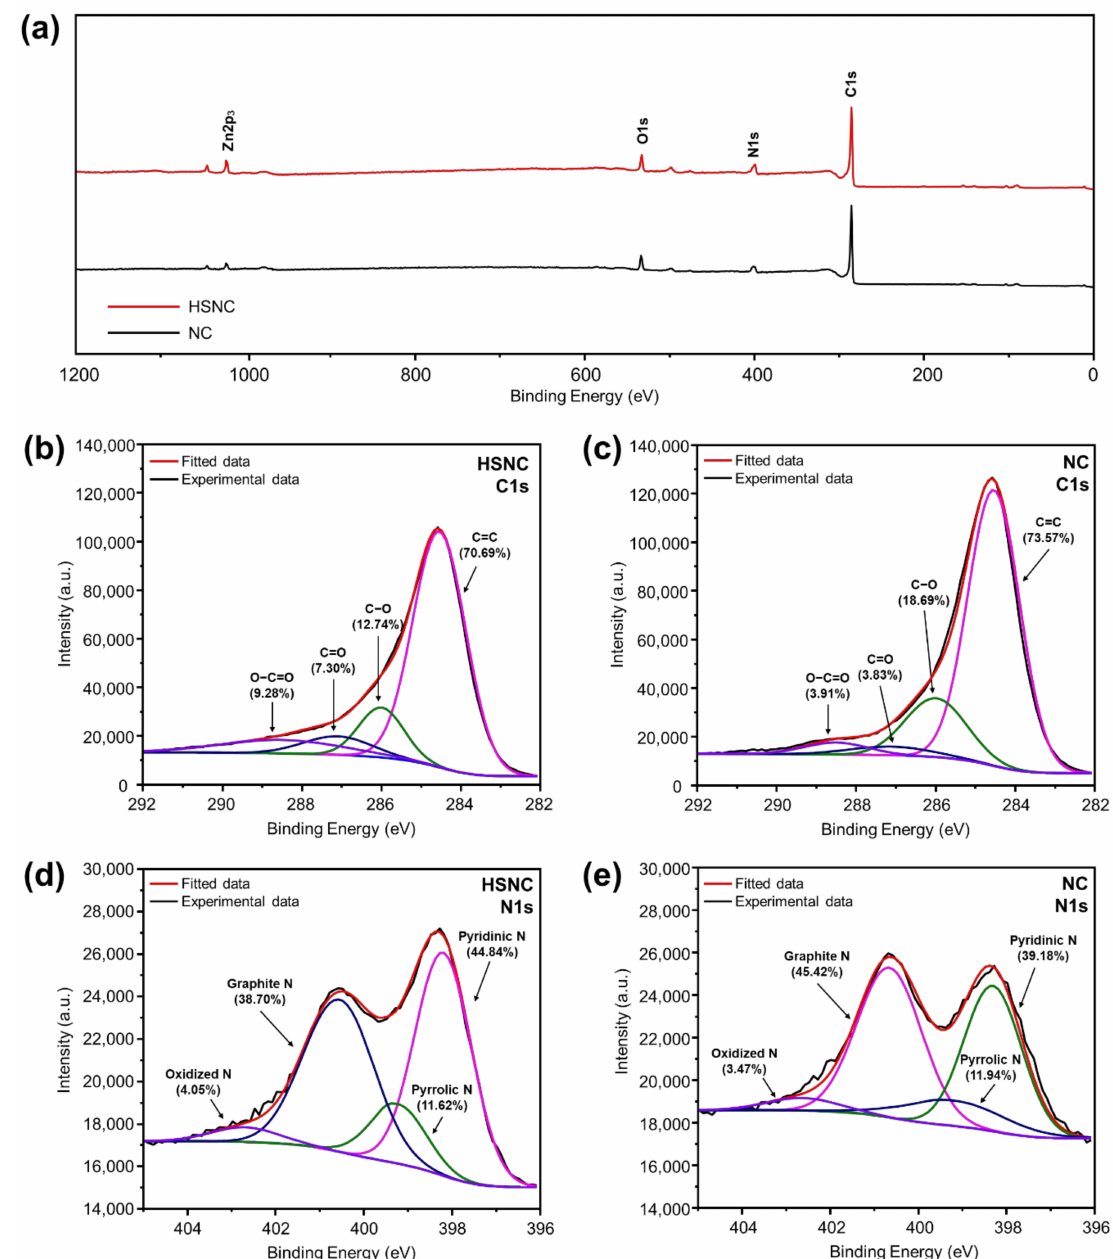
Figure 5. ( a ) XPS spectra of the HSNC and NC samples. C1s region of ( b ) HSNC and ( c ) NC samples. N1s regions of ( d ) HSNC and ( e ) NC